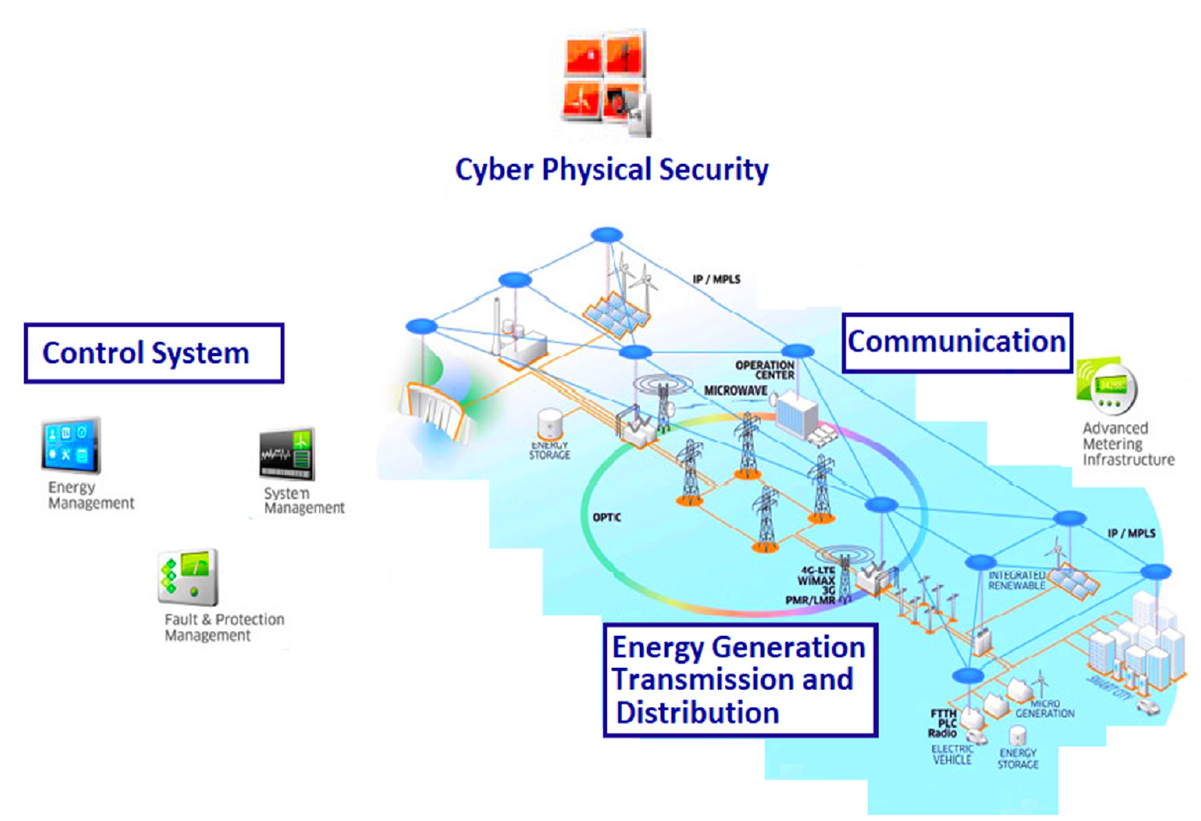
Figure 4. Smart Grid subsystems.